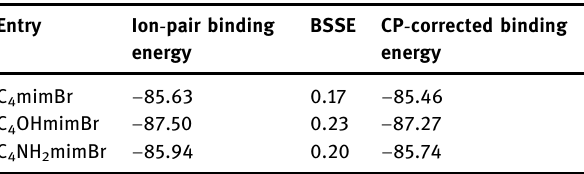
Table 3: Ion - pair binding energies, BSSEs, and CP - corrected binding energies ( kcal/mol ) , calculated at the B3LYP/6 - 311 + G